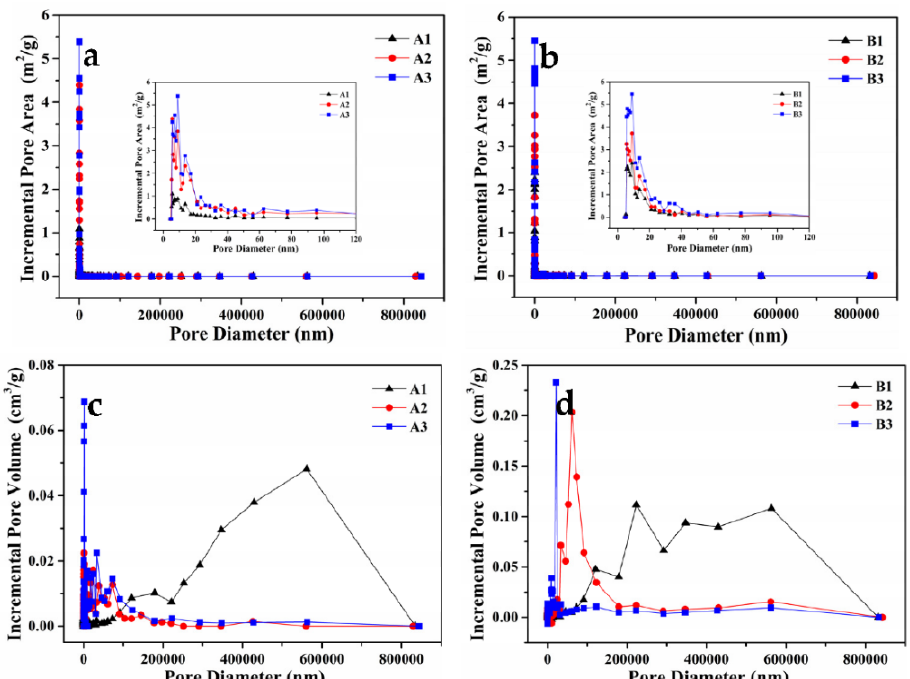
Figure 2. Curves of incremental pore area vs. pore diameter of the mudstone ( a ) and coal ( b ) specimens with distinct granule diameters, and the inserts were the partial enlargement curves, the curves of incremental pore volume vs. pore diameter of the mudstone ( c ) and coal ( d ) specimens with distinct granule diameters.